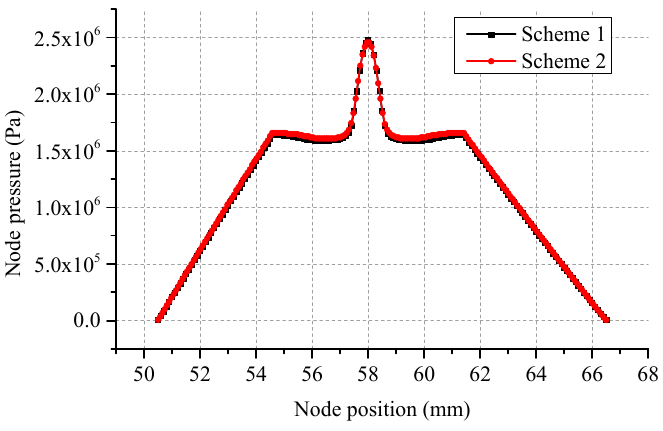
Figure 2. Pressure comparison of two meshing schemes along the line of a 1 – a 2 . Table 1. Comparisons of performance specifications of the hydrostatic thrust bearing with two different meshing schemes. Meshing